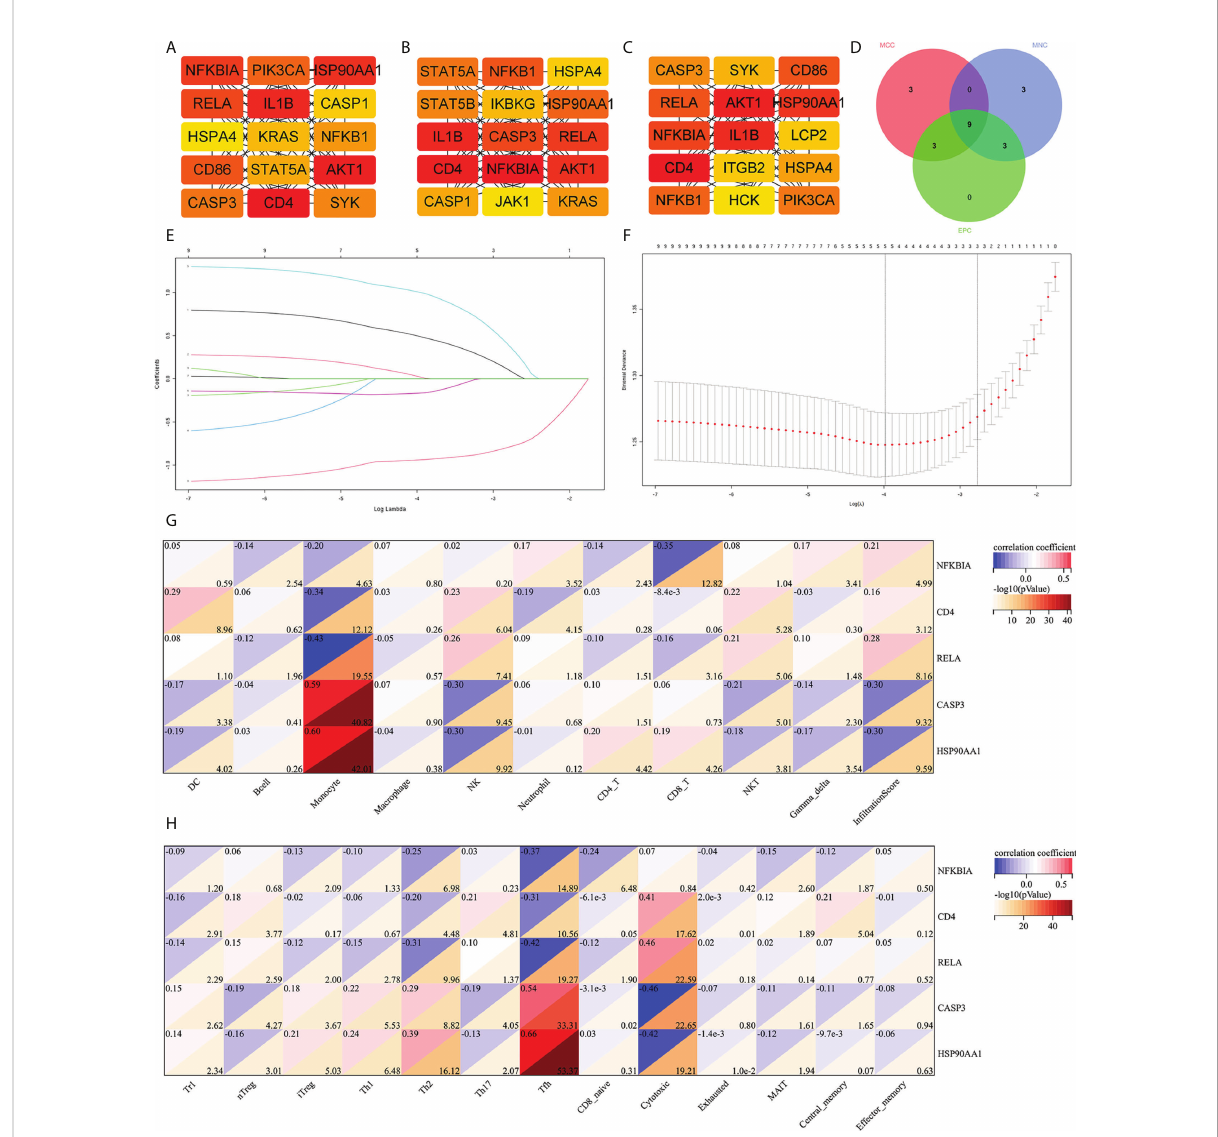
FIGURE 4 Screening of hub IRDEGs and their correlation with immune cell abundance. (A – C) The top 15 hub IRDEGs were screened by the EPC, MCC, and MNC algorithms of the cytoHubba plugin. (D) Venn diagram showing the common hub IRDEGs screened out by the EPC, MCC, and MNC algorithms. (E) LASSO coef fi cient pro fi les of the fi ve genes that met the prognostic criteria initially. (F) The misclassi fi cation error in the jackknife rate analysis. (G, H) The heat map showed the correlation between fi ve hub IRDEGs and 24 types of immune cell abundance and in fi ltration score. IRDEGs, immune-related different expression genes; HC, healthy control; MCI, mild cognitive impairment; AD, Alzheimer ’ s